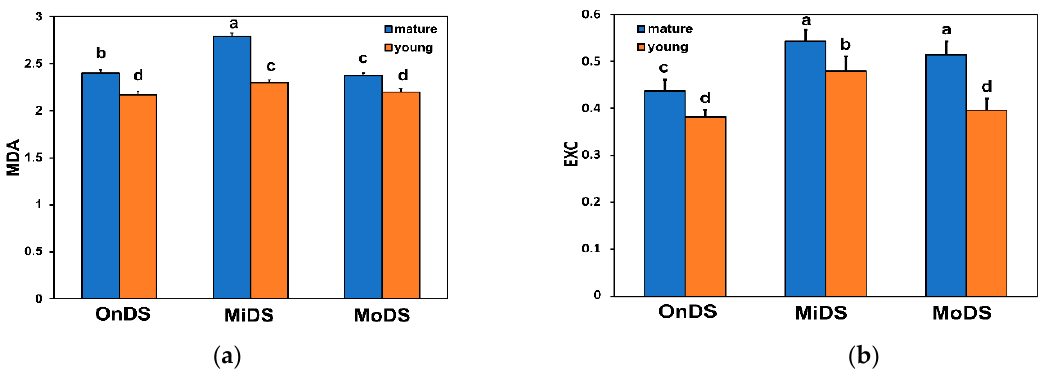
Figure 2. Changes in the level of lipid peroxidation, measured as nmol MDA g − 1 fresh weight ( a ) and in the excess excitation energy (EXC), estimated according to Demmig-Adams et al. [60] as: F v ΄ / F m ΄ x(1 − q p ) ( b ) , in A. thaliana young and mature leaves at the onset of drought stress (OnDS), at mild drought stress (MiDS) and at moderate drought stress (MoDS). Error bars represent ± standard error of the mean (n = 5–6). Bars with different lowercase letters are significantly different at p < 0.05.